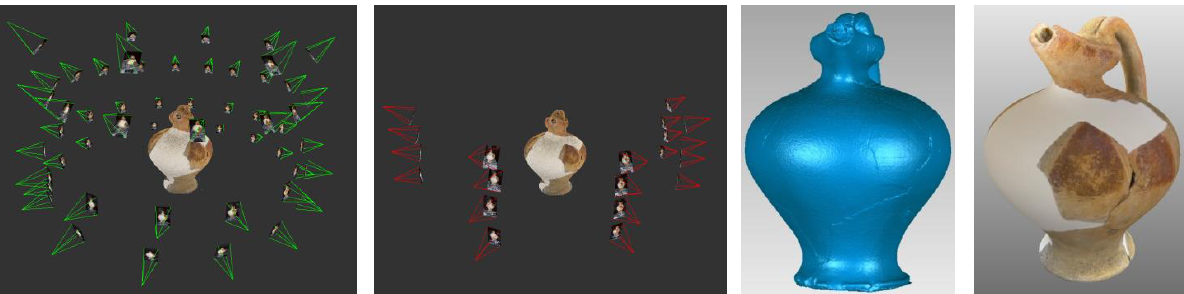
Figure 8: Imaging configuration for the ceramic jug: main imaging configuration without pattern projected onto the object (a); additional strips with images acquired with random pattern (b). Mesh model after the triangulation of the dense point cloud (c) and final textured 3D model (d).